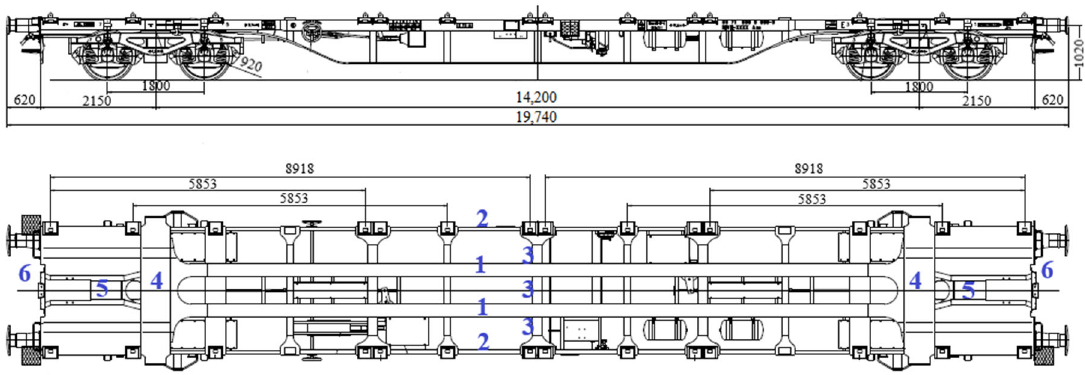
Figure 3. Sgnss wagon: lateral view and plan of the platform (dimensions in mm).